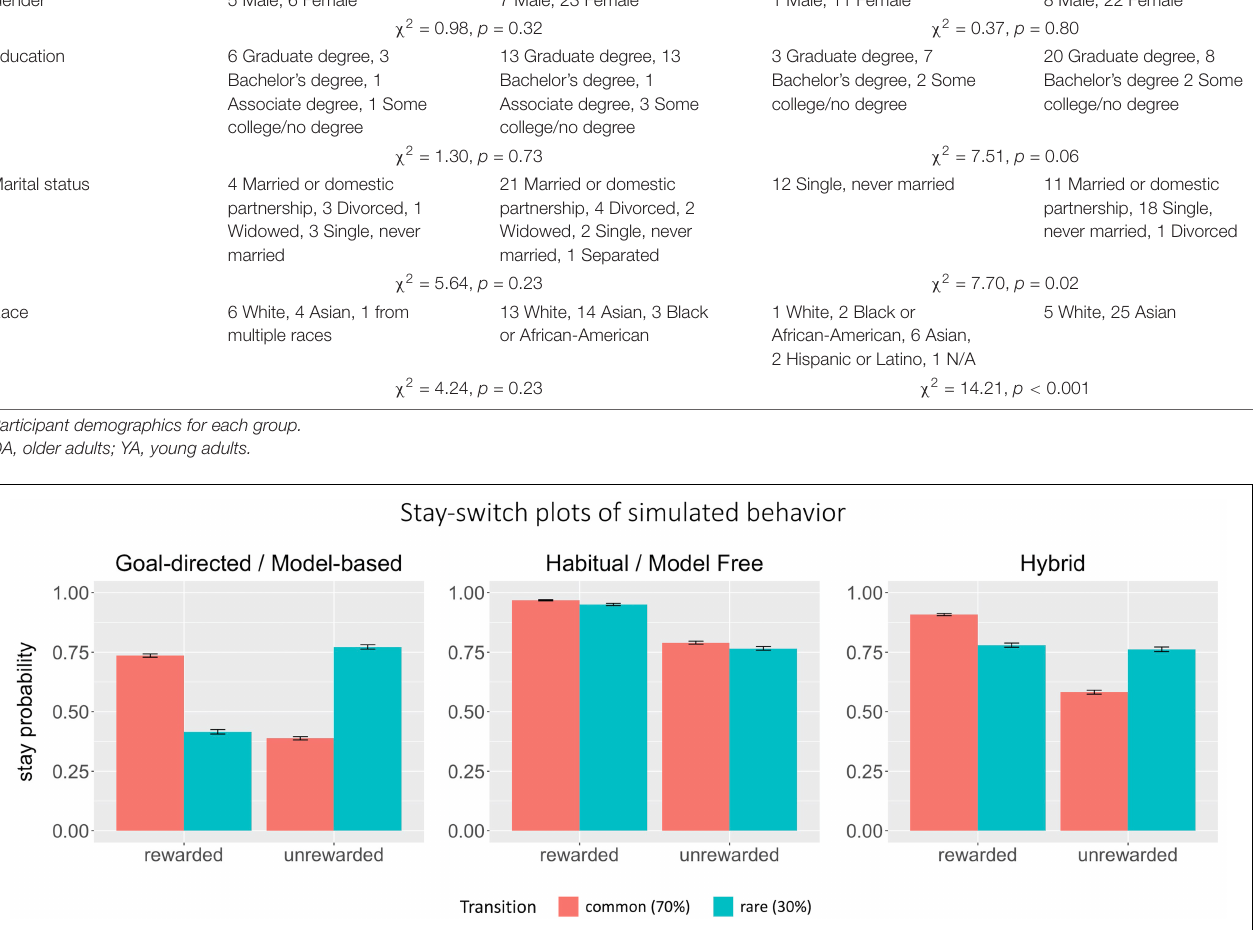
group was more diverse in racial distribution ( p <